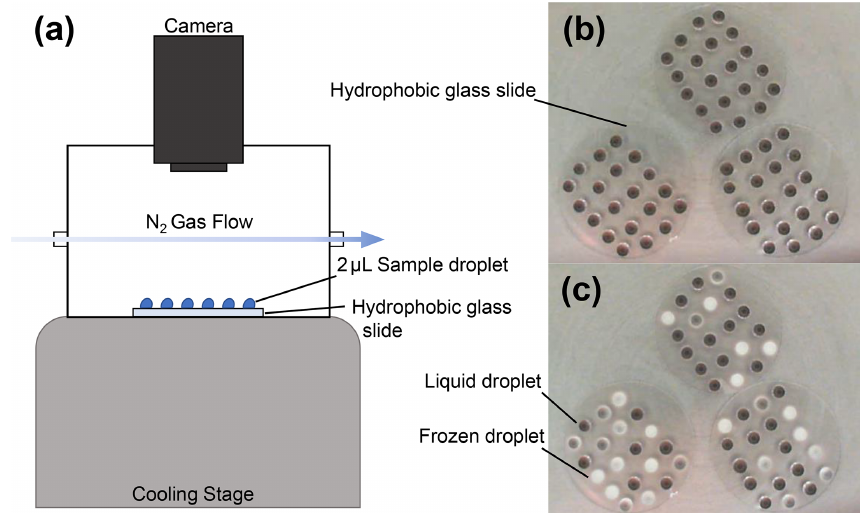
Figure 1. Experimental setup for droplet-freezing experiments. (a) Schematic of droplet-freezing setup. Images taken by the digital camera during freezing experiments with F. avenaceum , taken at approximately (b) − 3 ◦ C and (c) − 11.5 ◦ C. The diameter of each glass slide is